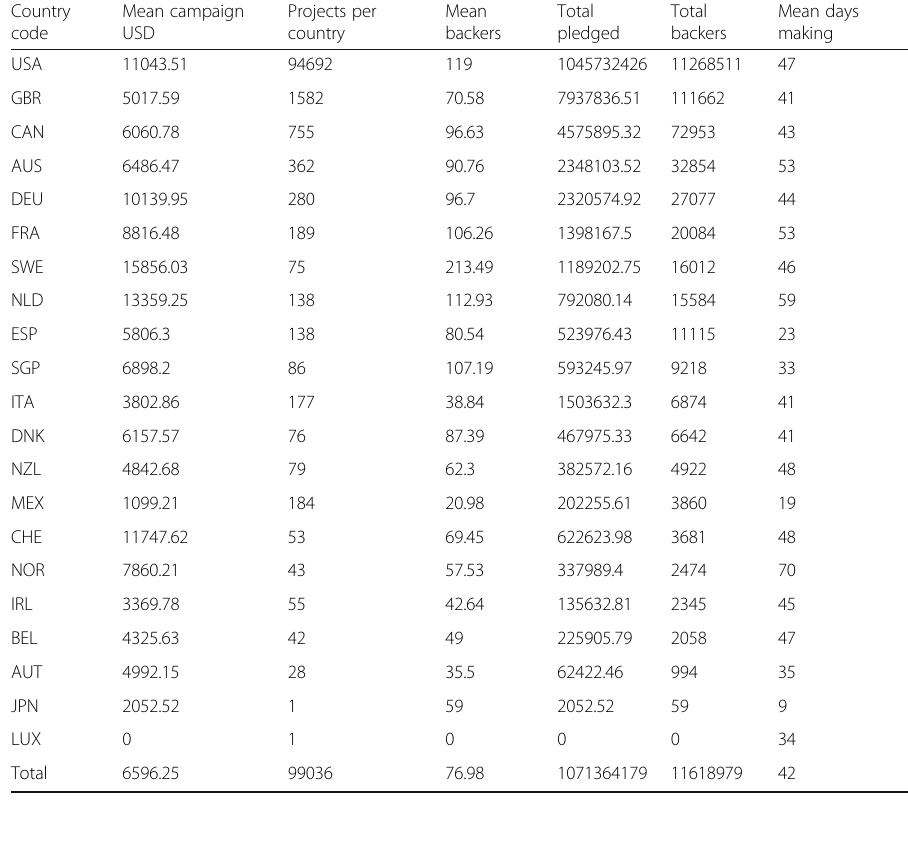
Table 1 Descriptive statistics of international distributions